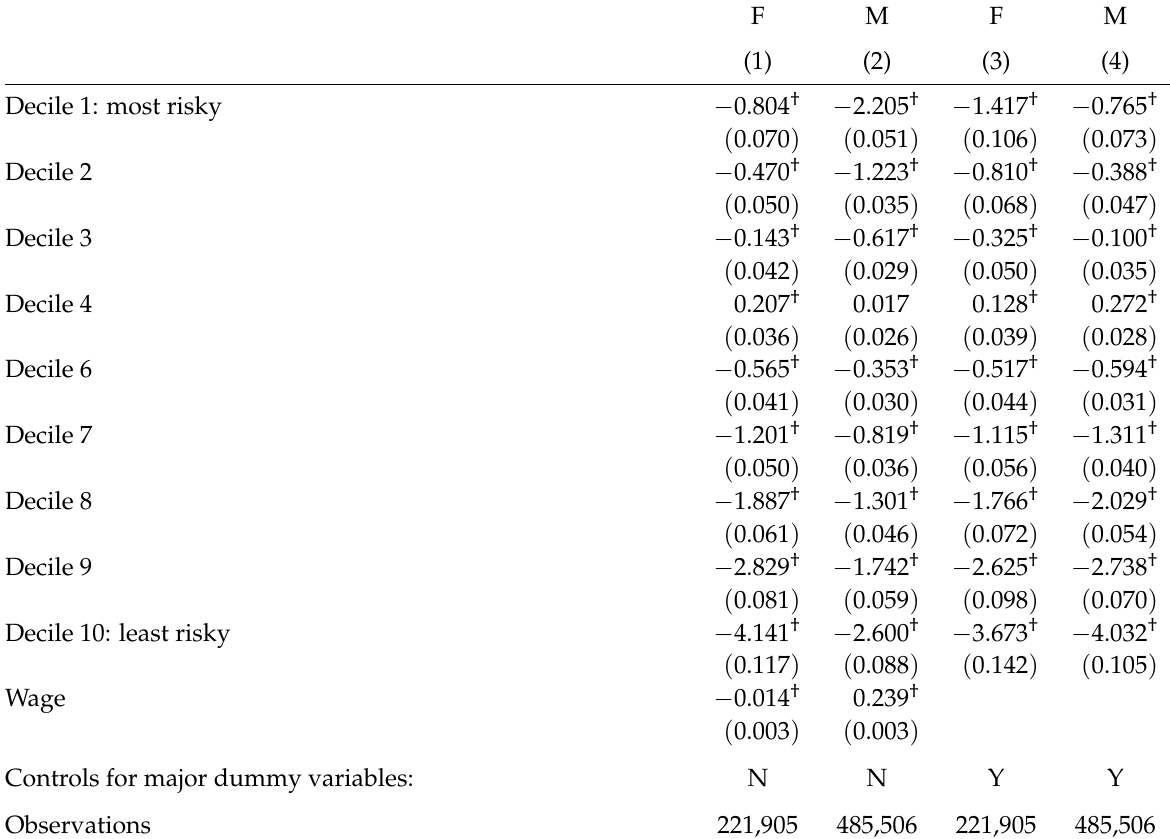
Table 4A: Multinomial Preferences Model: Effects of Expected Wage and Difficulty of Being Accepted, by Gender, on the First Choice,